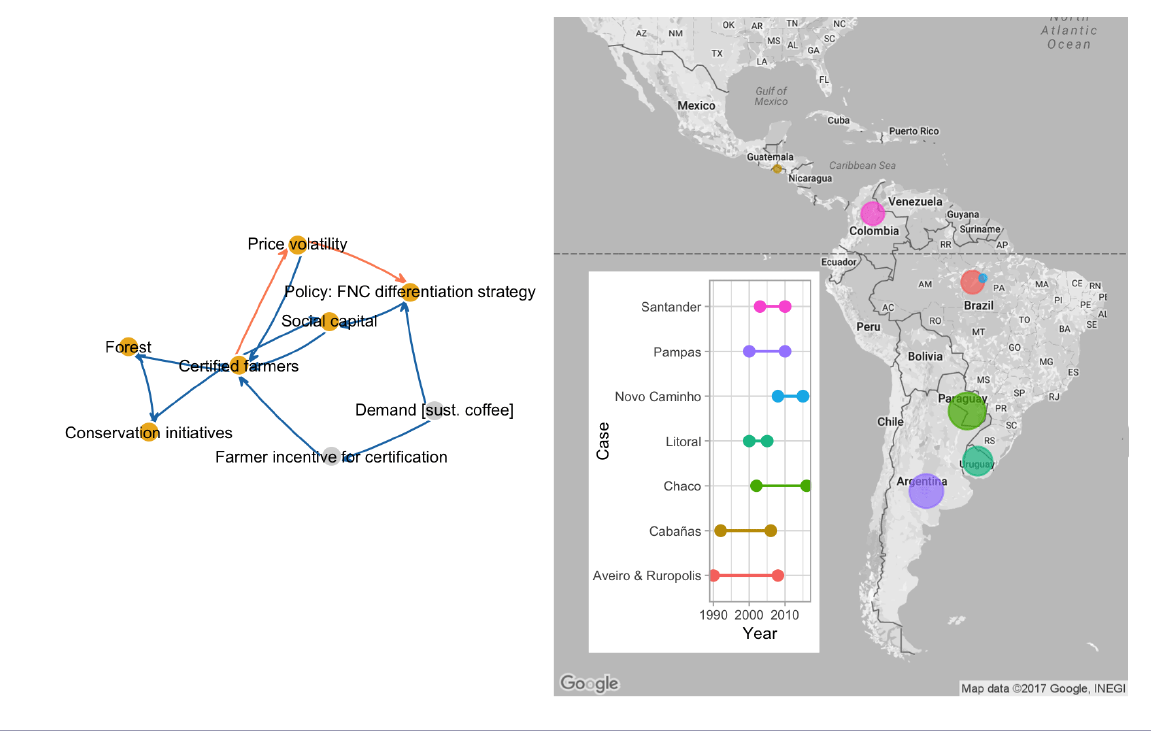
Fig. 1 . Case studies and causal-loop diagram (CLD example). Left: causal-loop diagram for the eco-certified coffee case study. Blue arrows denote positive relationships, orange arrows negative relationships. Variables in yellow belong to feedbacks whereas variables in gray are outside feedbacks; hence by definition they are external drivers: their dynamic behavior does not depend on the state variables of the system. Right: map with case studies. Circle size is proportional (in log-scale) to the area that the case study describes. The inset shows the temporal horizon at which each case study is described. For details on summary categorical variables from the template see Table 1, and a summarizing description of each case study see Table 2. Geographic information was obtained from Google Maps